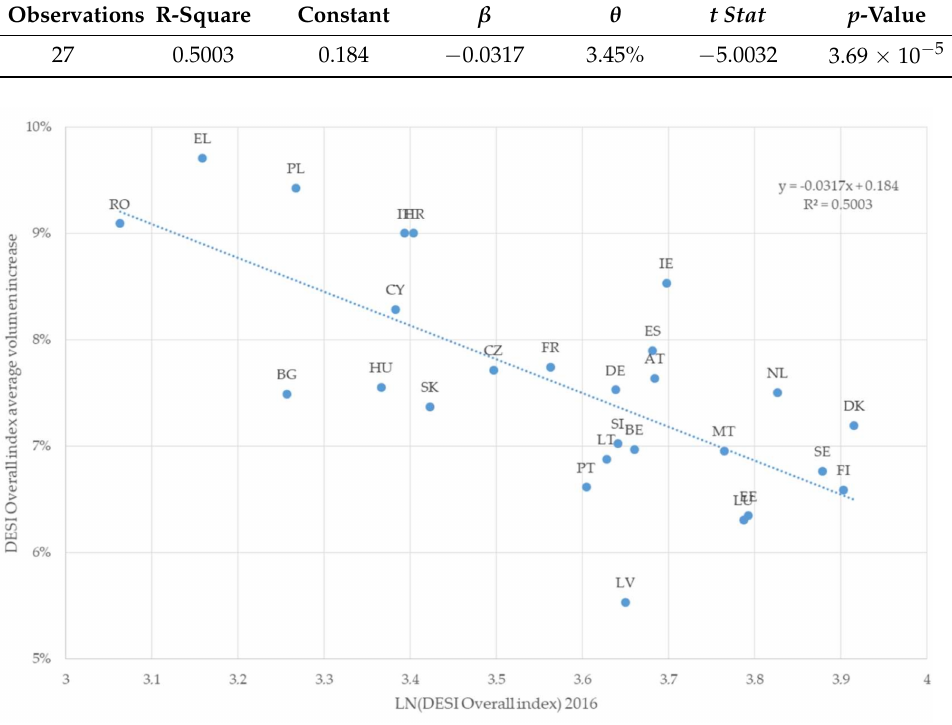
Figure 4. β -Convergence of DESI overall index